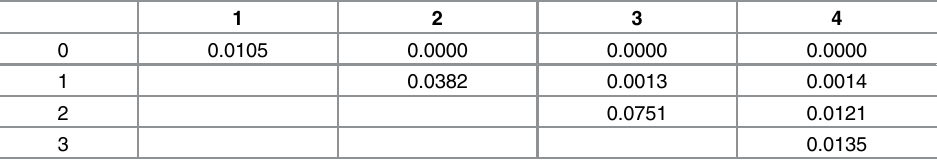
Table 12. Character transition likelihoods for symmetrical hatchling precociality character transition